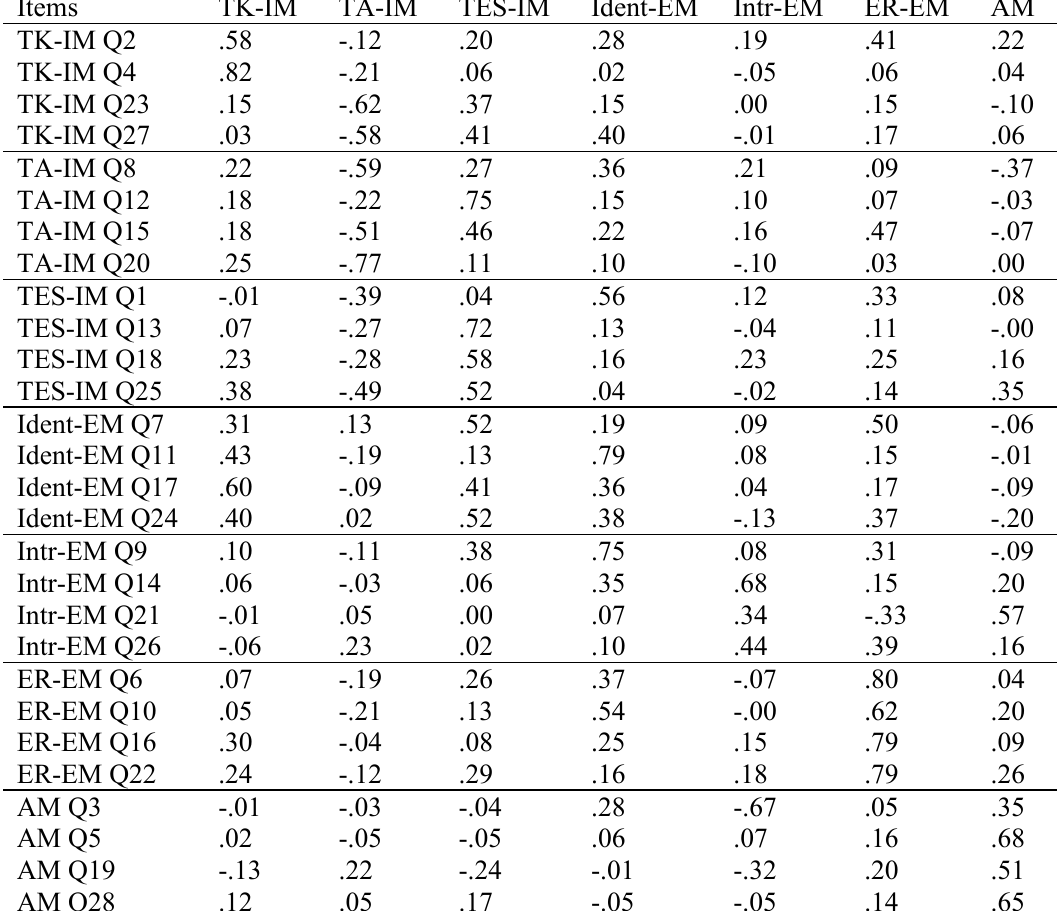
Table 3. Factor loadings for principal components factor analysis with direct oblimin rotation of items of the